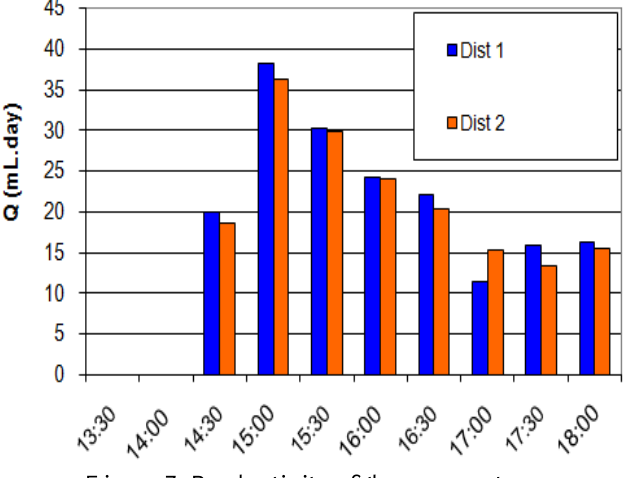
Figure 7. Productivity of the pure